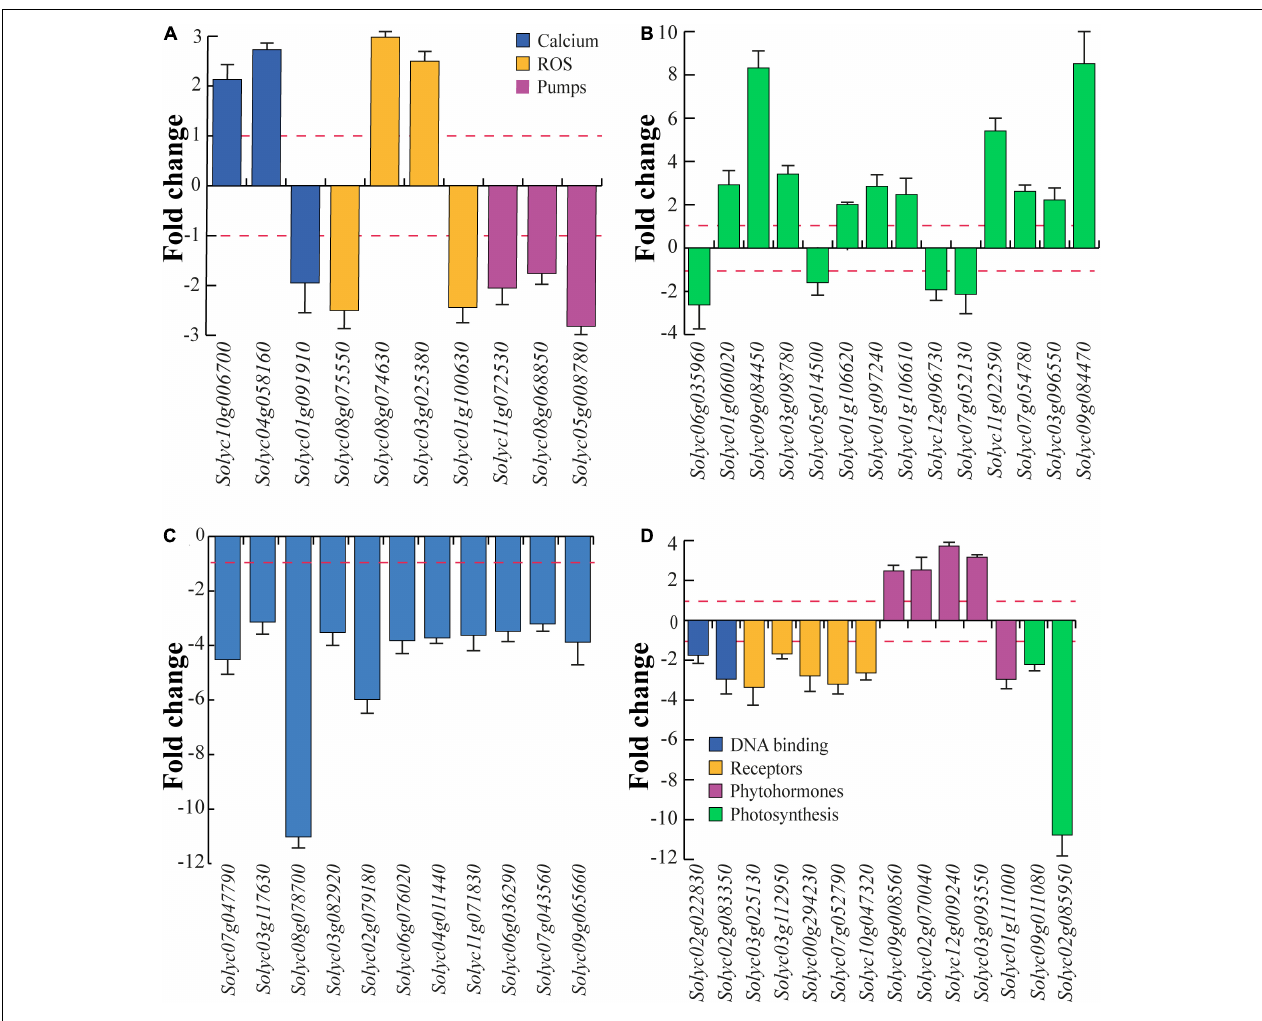
FIGURE 6 | Differential gene expression of tomato selected genes in response to eDNA. The data are expressed as fold change in relation to controls (intact DNA). To emphasize the visualization of data, fold change values below 1 were plotted as –1/value, in order to obtain negative fold change values (indicating downregulation). (A) Gene expression of calcium-, ROS-, and proton pump-related genes. (B) Genes involved in plant defense. (C) Gene expression of heat shock proteins and heat shock factors. (D) Gene expression of DNA binding-, receptor like-, phytohormone-, and photosynthesis-related genes. In all figures, the red dotted lines represent the control (intact DNA) level; metric bars indicate standard deviation ( N =